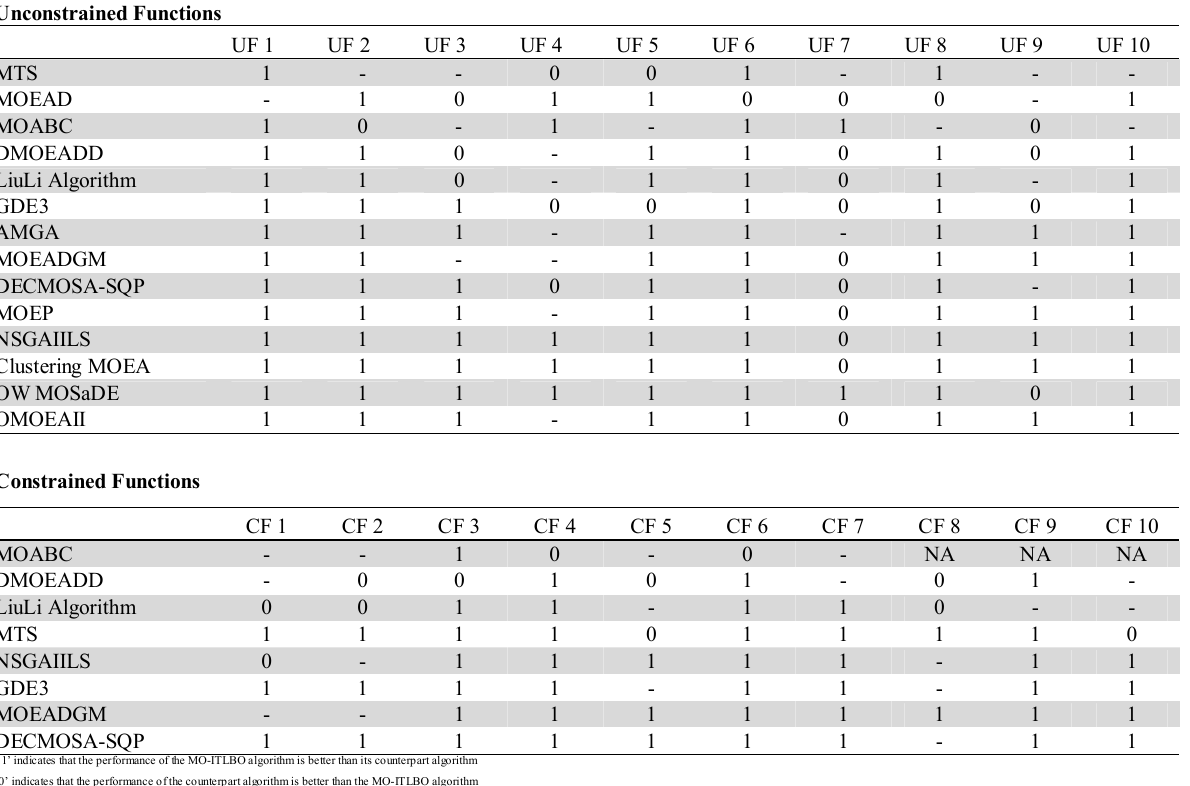
Pairwise comparison of the MO-ITLBO algorithm with the other algorithms for unconstrained and constrained test